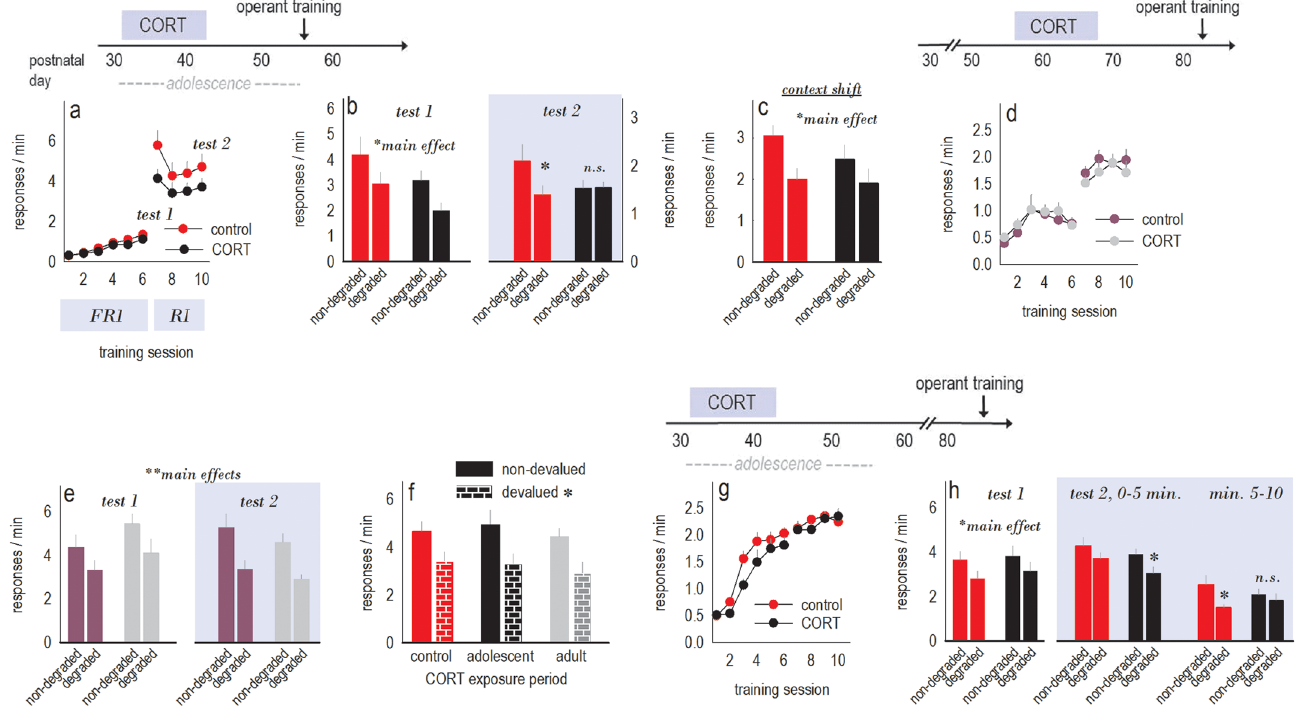
Fig 2. Greater vulnerability to CORT-induced habits in adolescents than adults. Experimental timelinesare positionedabovethe response acquisitioncurves associatedwith each experiment. Response acquisitioncurves represent both responses/min, and breaks in the curves represent tests for sensitivity to instrumental contingency degradation. (a) Instrumental responseacquisitionwas intact 2 wk followingadolescent CORT exposure.Text belowthe x axis notes the schedulesof reinforcement used throughout(FR1 before test 1, followedby an RI schedule).(b) Sensitivity to instrumental contingency degradationwas also initiallyintact (test 1) in that mice inhibiteda responsethat was unlikelyto be reinforced(“degraded” condition),but CORT-exposed mice then developed habit-based response strategies, failing to differentiatebetweenresponses (test 2). n = 8–9/ group. (c) In a separate group, test 2 was conductedin a distinct environment (“context shift”). In this case, all mice preferentially engagedthe response most likely to be reinforcedin a goal-directed manner, indicating that CORT-induced habits (in b) are context dependent. n = 7/group. (d) A history of subchronic CORT exposurein adulthood also did not impact instrumental responseacquisition. (e) Unlike with adolescent CORT exposure, however,both groups inhibiteda responsethat was unlikelyto be reinforced in a goal-directed fashion. n = 7/group. (f) Additionally, all mice inhibited respondingfollowingprefeedingwith the reinforcerpellets (“devalued”), relativeto prefeedingwith chow (“non-devalued”), regardless of age of CORT exposure.(g) Another group of adolescent CORT-exposed mice was alloweda longer(4-wk) washout periodin order to match the timing of testing in adult CORT-exposed mice. Mice acquiredthe responses without group differences. (h) Responsepreferences were intact in test 1, as above. During test 2, mice were initiallyable to differentiate betweenthe responses that were likely versus unlikelyto be reinforced,but response preference decayed in the CORT-exposed mice. n = 11–12/group. Bars/symbols= means + SEMs, * p < 0.05, ** p < 0.001 versus nondegraded or main effects, as indicated.Raw data for this figure can be found in S1 Data. CORT, corticosterone; FR1, fixed ratio 1; RI, random